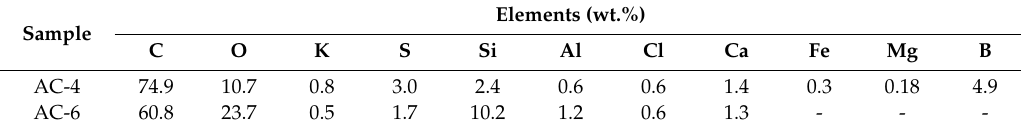
Table 2. Elemental chemical composition of the peat-derived activated